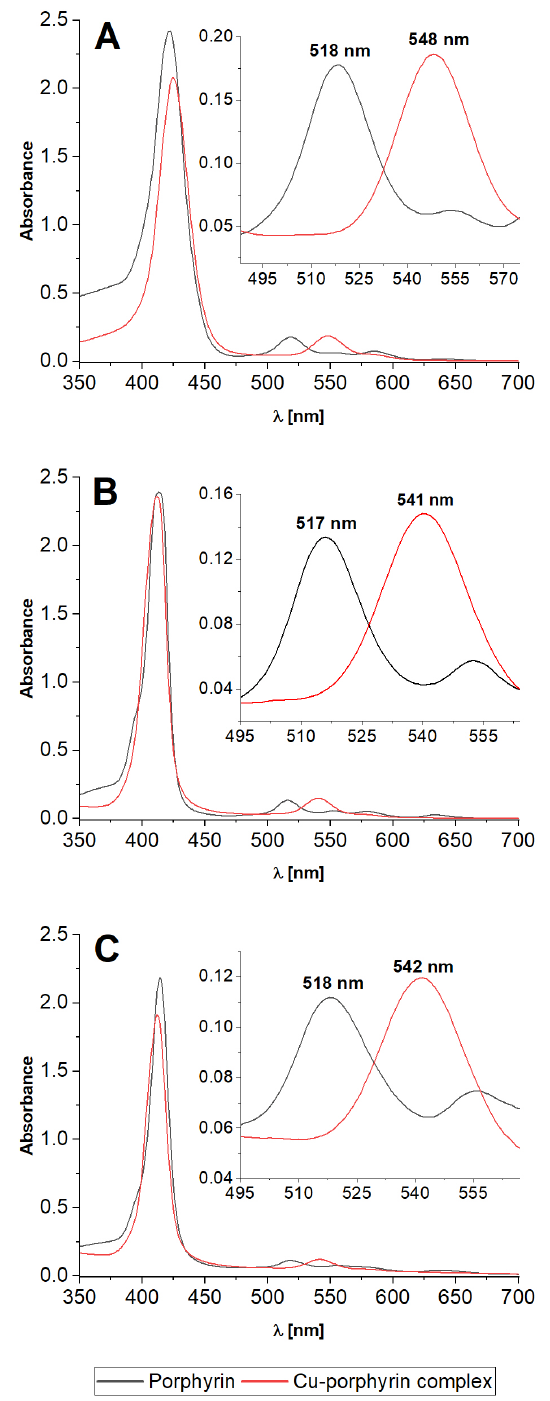
Figure 3. Spectra of studied porphyrins and corresponding Cu complexes: ( A ) TSPP, ( B ) TMPyP, ( C ) TCPP. [Cu-porphyrin] = [Porphyrin] = 10 − 5 mol L −1 ; pH 9.